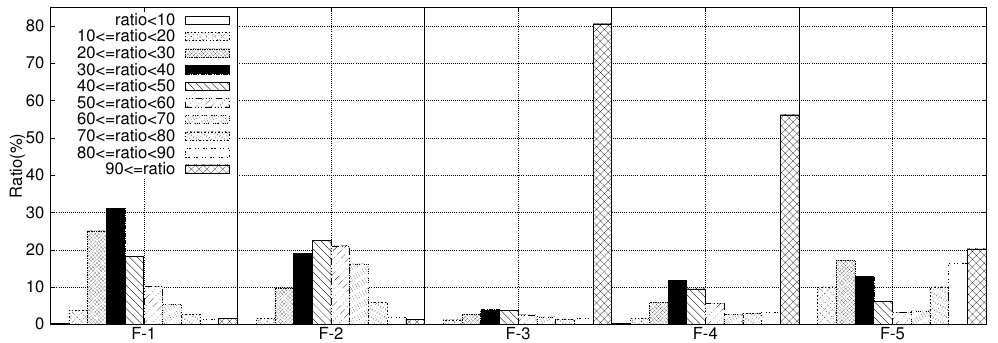
Figure 7. Distribution for compressions for each